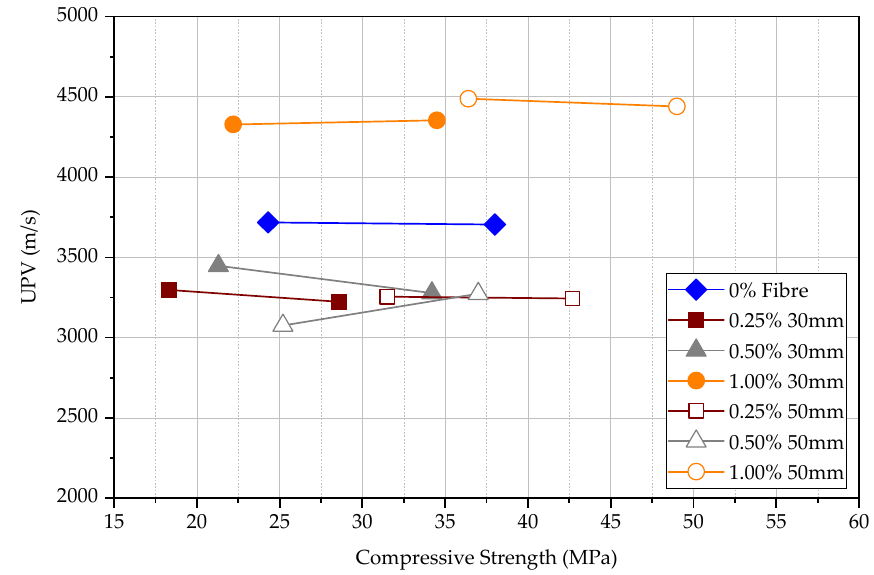
Figure 17. Semi-direct UPV measurements vs compression strength.